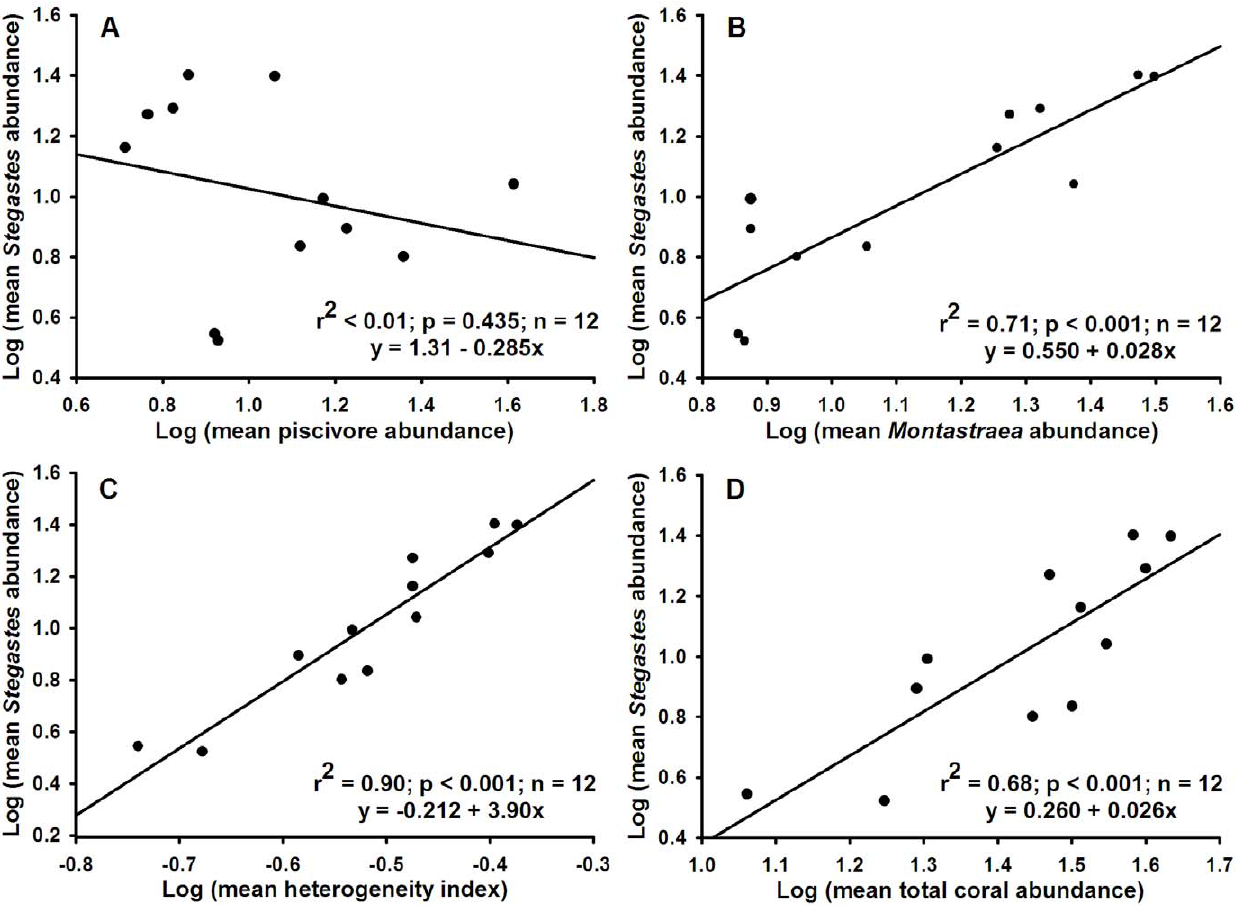
Figure 3. Relationships between key parameters and the abundance of S.planifrons . The abundance of S. planifrons regressed on: (A) piscivore abundance; (B) proportional cover of the Montastraea annularis species complex; (C) structural complexity; and (D) proportional cover of total hard corals. The coordinates of each point are the log-transformed means of the transects within a site.